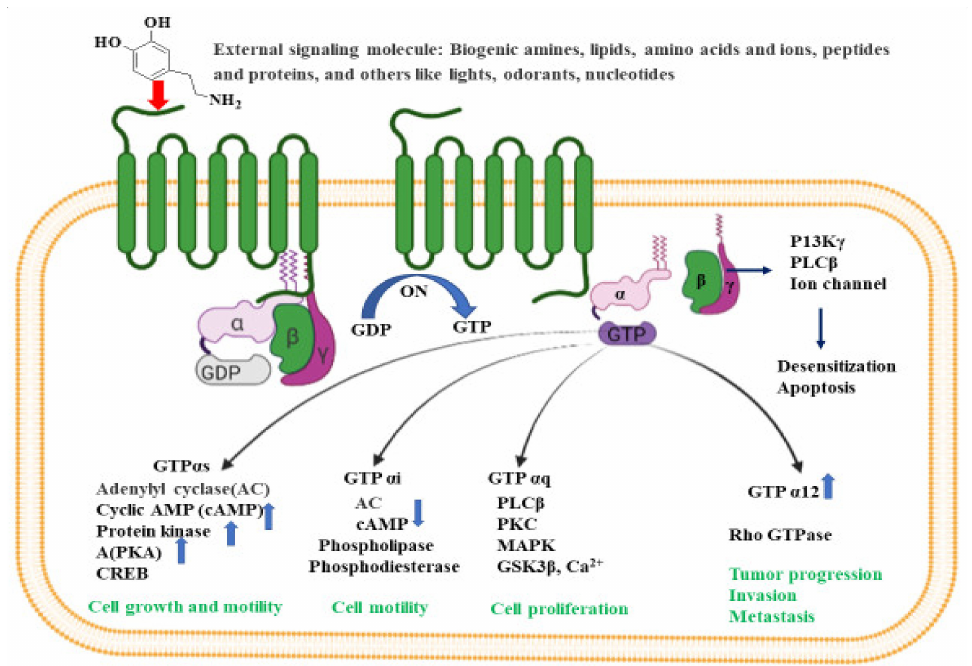
Figure 2. Intracellular signaling pathways for GPCR. Inactive GPCR exists as a complex unit consisting of α subunit bound to GDP and the βγ subunits. The binding of external signal molecules to a GPCR makes it active and results in a conformational change. During conformation, the GDP of α subunits forms to GTP, and the separation of α and βγ subunits occurs. When an active G α subunit dissociates from the GPCR, it may interact with other proteins, triggering a signaling pathway that leads to cell growth and motility, cell proliferation, tumor progression, invasion, metastasis etc., depending on the binding proteins. The figure was created using tools obtained from BioRender.com. Many physiological processes result from a signal (e.g., lipids, peptides, proteins,